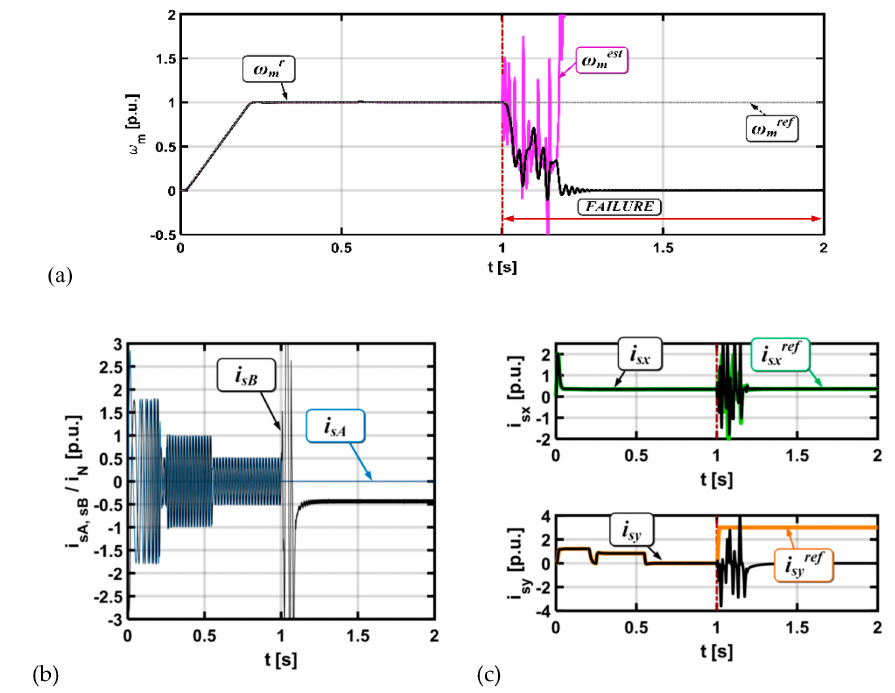
Figure 4. Results for the drive system with a broken current sensor in phase A (lack of signal), (rotor speed ( a ), stator current ( b ), stator current components x,y ( c )), i A’ = 0.